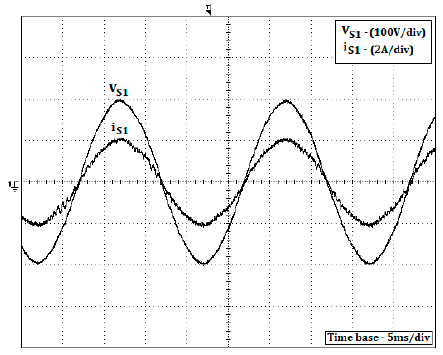
Figure 14. Experimental result of the grid voltage (V S1 ) and current in phase 1 (i S1 ).